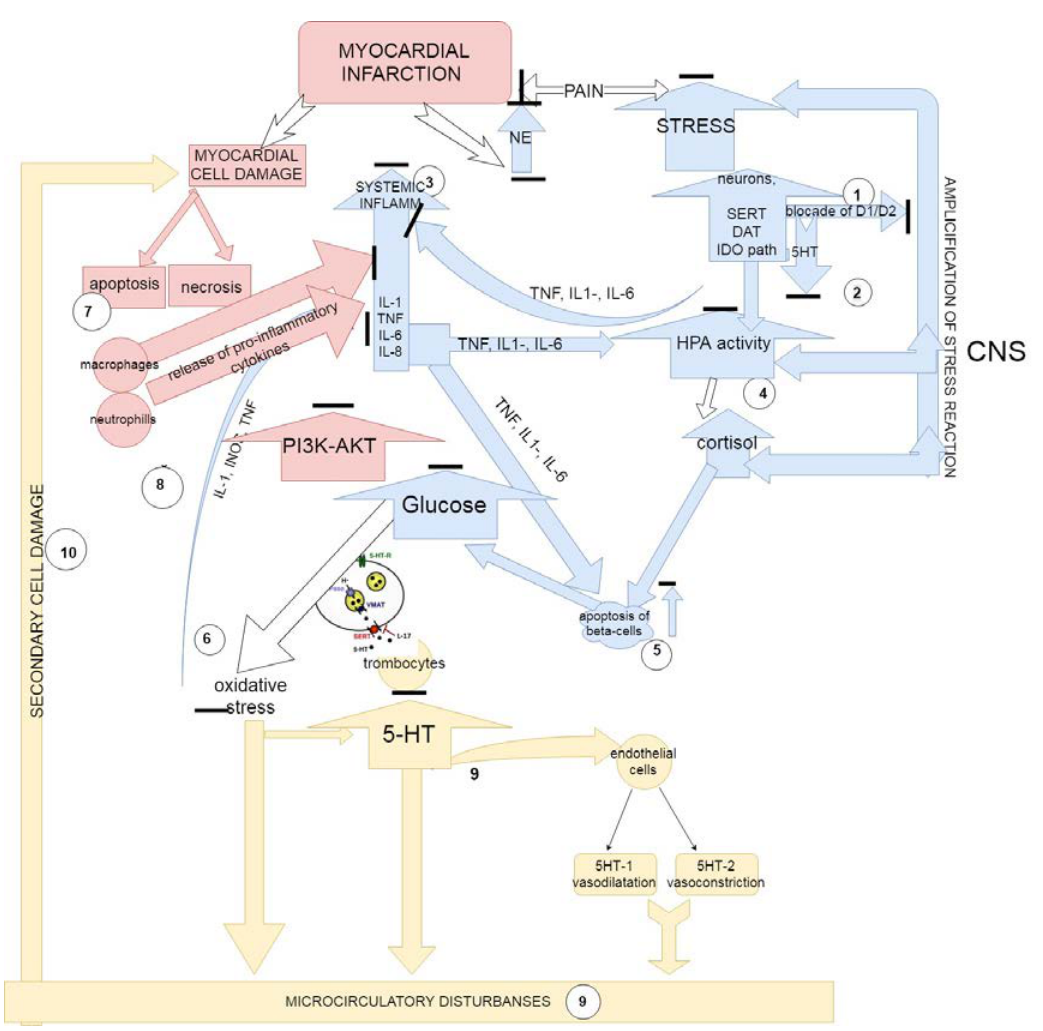
Figure 4. The proposed immunopathophysiological mechanisms of stress-limiting effects of 1,3,4-thiadiazine compounds in myocardial infarction (based on the compound L-17 properties). Legend: blue—the main mechanisms of action of the substituted 1,3,4-thadiazines on the course of stress reaction are highlighted; red—mechanisms acting on the tissue damage; yellow—action of the compounds on the serotonin-mediated disorders of microcirculation. Systemic effects of 1,3,4-thadiazines included: (1) the increase in neuronal stress-resistance mediated through D2 receptors; (2) the increase in synaptic availability of 5-HT, mediated via SERT and M1 receptors; (3) the reduction in the levels of stress cytokinemia, mediated via NET, M1 and D2 receptors; (4) the reduction of stress hormonal response and sensitivity of pituitary-adrenal system mediated through blockade of M1 receptors; (5) the reduction of stress-mediated decrease in insulin production in the pancreas and prevention of stress hyperglycemia due to action on dopamine receptors; (6) the decrease in of blood glucose levels, which, on the background of M-cholinoreceptor blockade, led to the decrease inoxidative stress in tissues. Local effects of substituted 1,3,4-thadiazines included: (i) the reduction of oxidative stress levels and the suppression of the intensity of the local inflammatory process by inhibiting chemotaxis and migration of leukocytes, which was mediated through the blockade of muscarinic receptors and the kinase signal pathway PI3K-AKT; (7) the increased apoptosis, increased macrophage infiltration, decreased macrophage release of proinflammatory cytokines via blockade of D-receptors; (8) the decreased platelet activation and aggregation preventing the development of microcirculatory disorders and, as a consequence, secondary damage to the myocardial tissues (9–10) through a synergistic blockade of the serotonergic and adrenergic